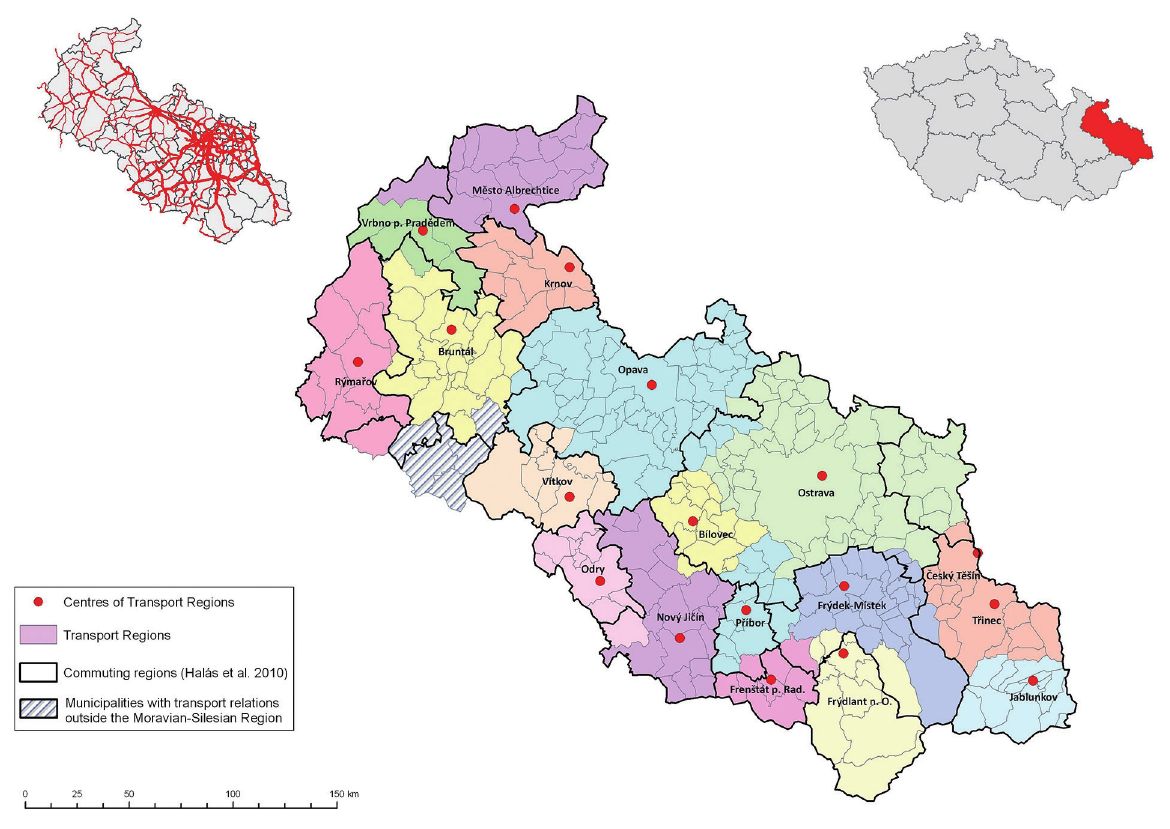
Fig. 5. Comparison of transport regionalisation and commuting regionalisation: Moravian-Silesian Region Source: RTC 2010, Halás et al. (2010), own